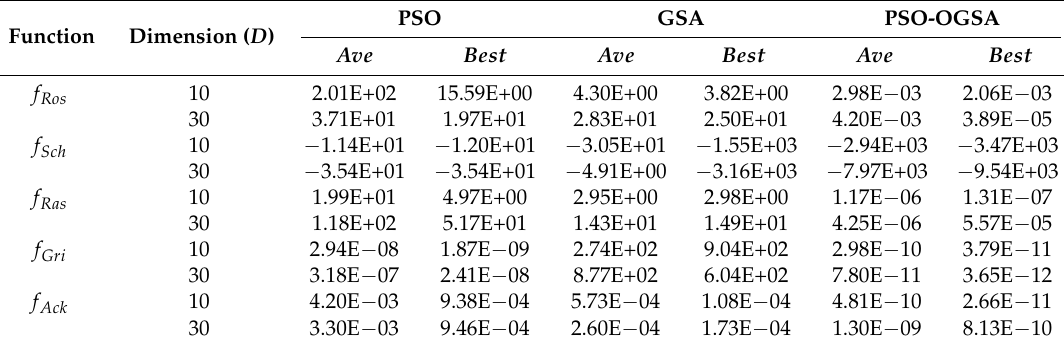
Table 3. The mean best fitness of different methods for five benchmark test functions.